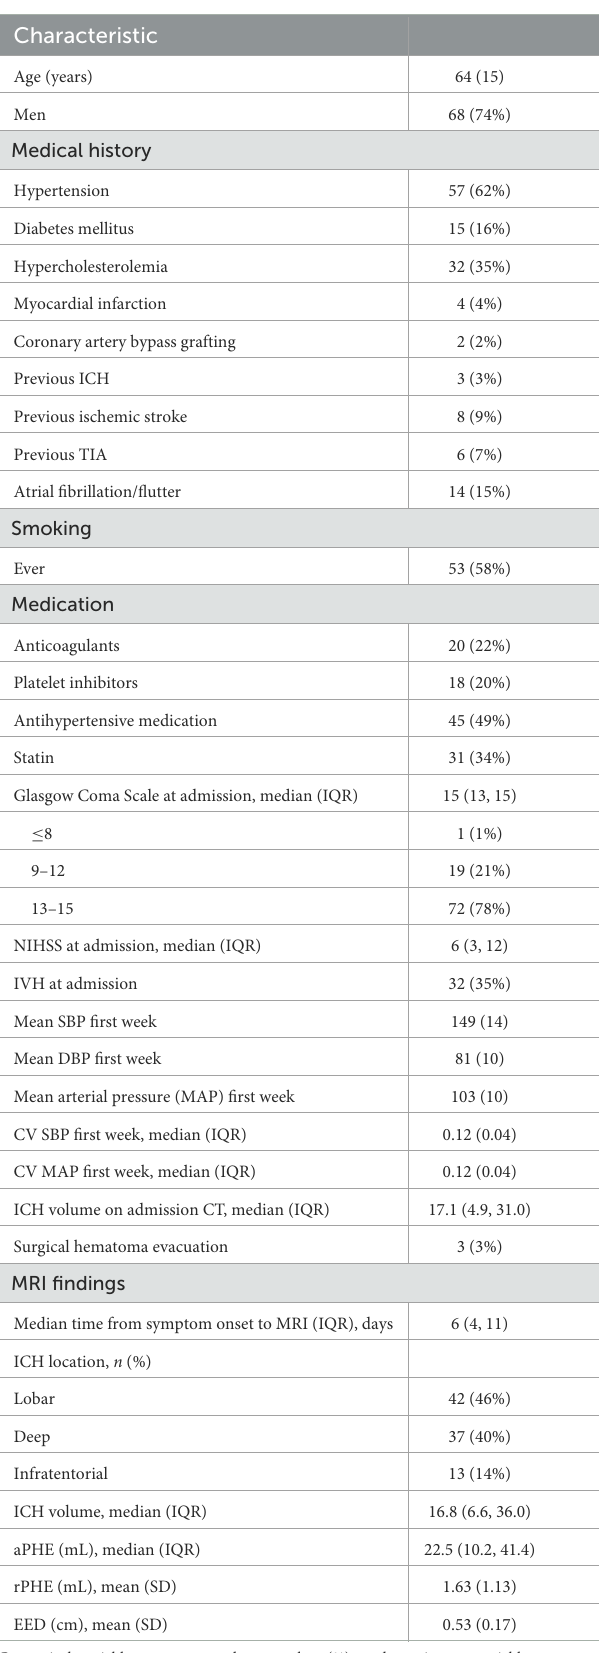
TABLE 1 Baseline characteristics and MRI findings of included patients ( n =